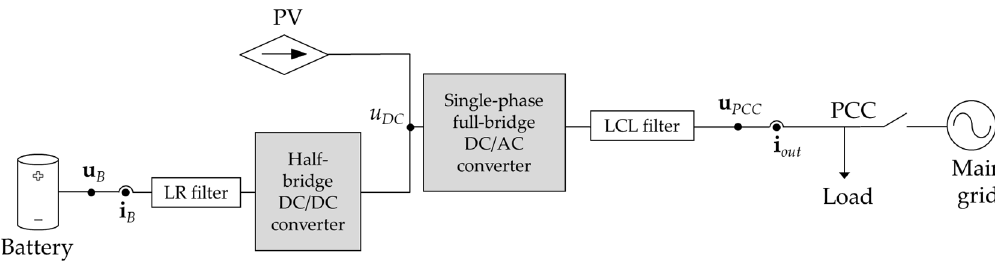
Figure 7. Circuit scheme of each prosumer’s system, including PV generation, battery based energy storage systems (ESS), power converters and load.